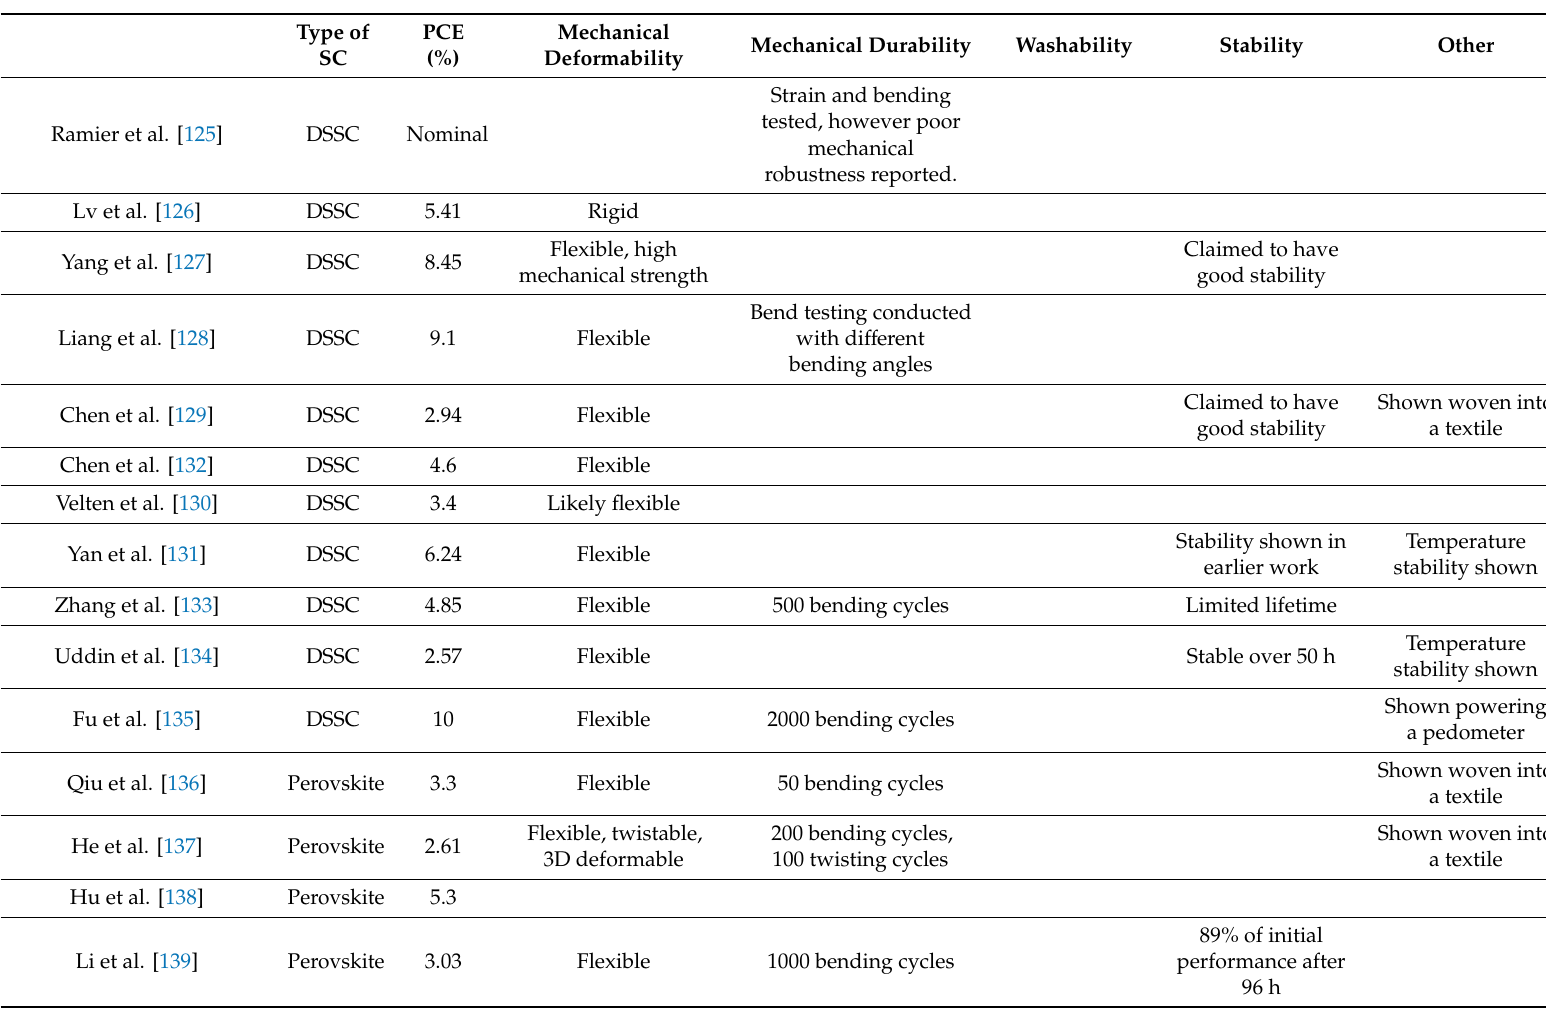
Table 2. Summary of key information regarding the reported properites of various photovoltatic wires, fibers, and yarns. Please note that PCE (%) are the values given and do not account for any di ff erences in how the PCE may have been calculated between